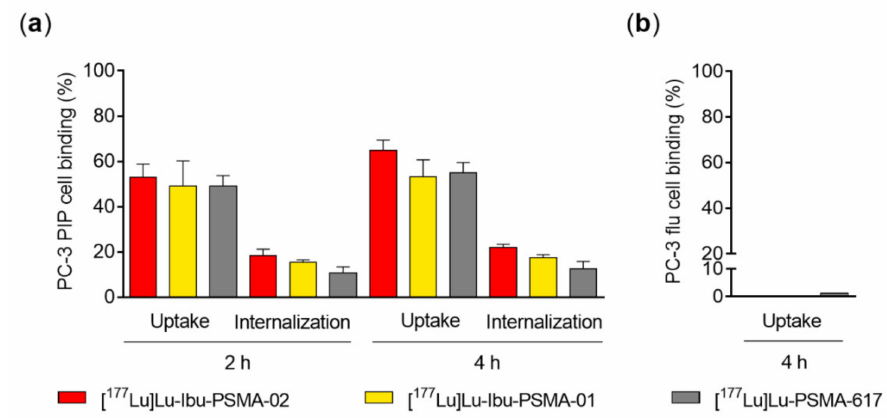
Figure 3. Uptake and internalization of [ 177 Lu]Lu-Ibu-PSMA-02 in comparison to [ 177 Lu]Lu-Ibu-PSMA-01 [17] and [ 177 Lu]Lu-PSMA-617 [11]. ( a ) Data obtained in PSMA-positive PC-3 PIP cells ( n = 3). ( b ) Data obtained in PSMA-negative PC-3 flu cells ( n = 3). Data of [ 177 Lu]Lu-PSMA-617 were adapted with permission from Benešov á et al. 2018 Mol Pharm 15: 934. Copyright 2020 American Chemical Society [11]. Data of [ 177 Lu]Lu-Ibu-PSMA-01 were adapted from Deberle and Benešov á et al. 2020 Theranostics 10:1678